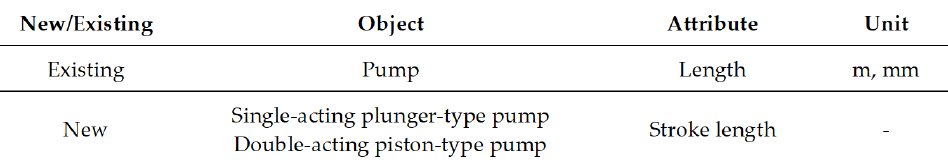
Figure 10. The extended concepts and relationships of domain ontology for Figure 1.